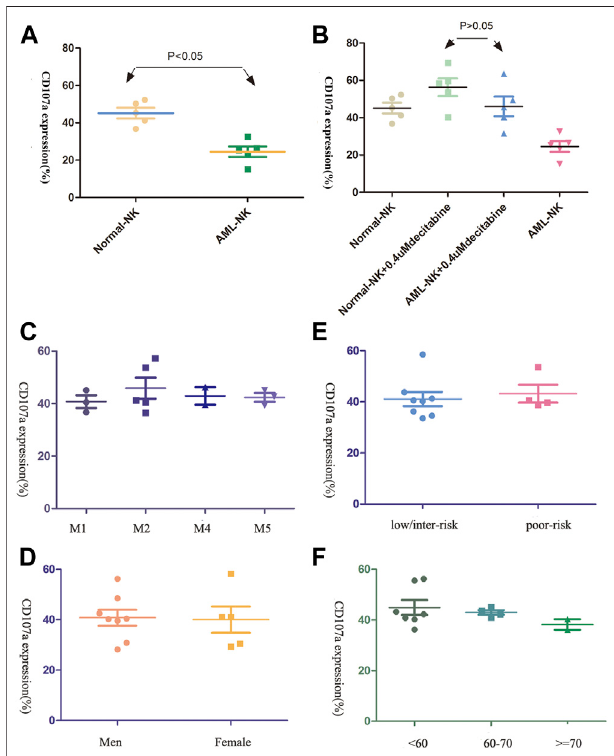
FIGURE 2 | The cytotoxicity of primary NK cells was seldom in fl uenced by patients clinical characteristics (A,B) The cytotoxicity of AML-NK cells was impaired relative to that of Normal-NK cells (** p < 0.05). Cytotoxicity of AML- NK cells was nearly equal to that of Normal-NK cells when treated